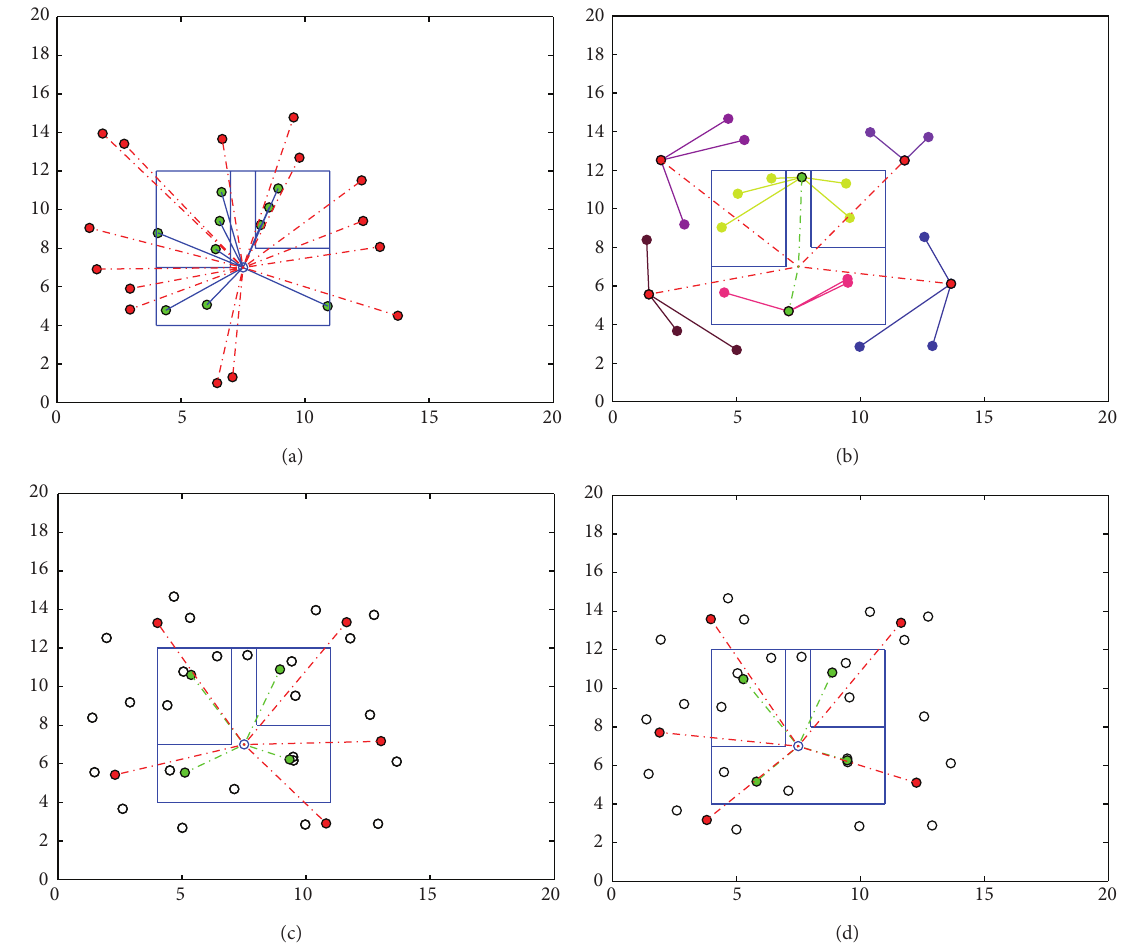
Figure 11: (a) Position of the sample indoor and outdoor users. (b) AP clustering of indoor and outdoor users based on signal strength. (c) K -means clustering with 9 clusters. (d) Fuzzy c -means clustering with 9